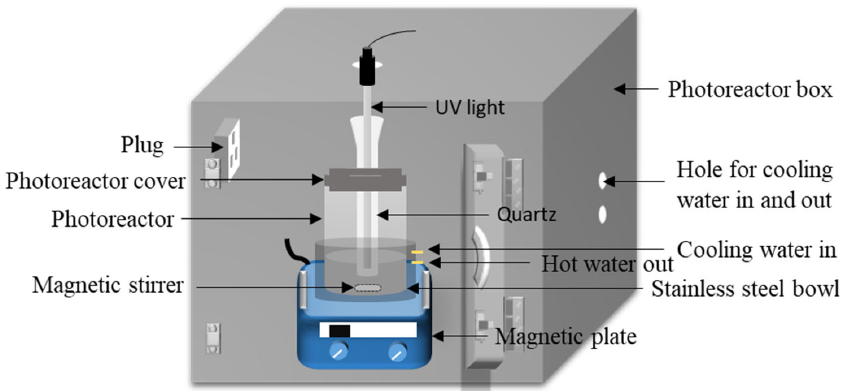
Figure 1. The photocatalytic reactor used in this study.